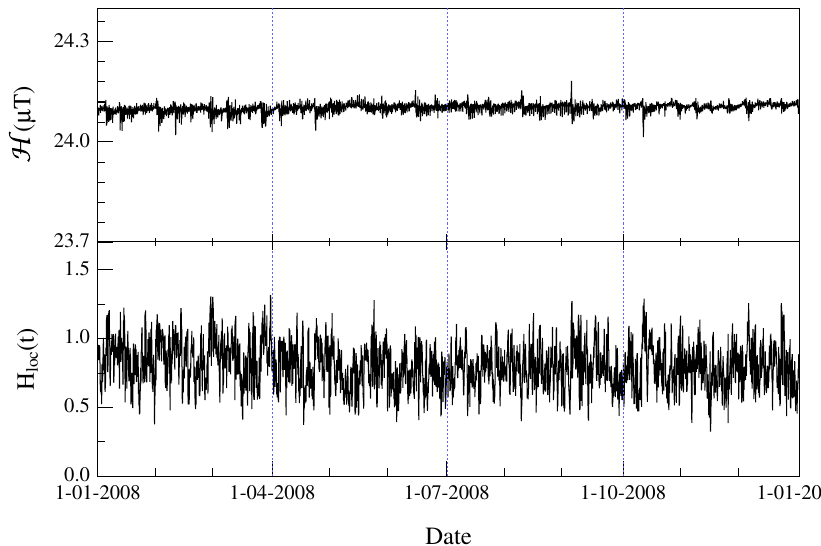
Fig. 11. The geomagnetic field H component, as measured at L’Aquila Geomagnetic Observatory (Italy) in 2008 (upper panel), and the corresponding local Hurst exponent H loc (t) (lower panel), computed using the DMA technique.